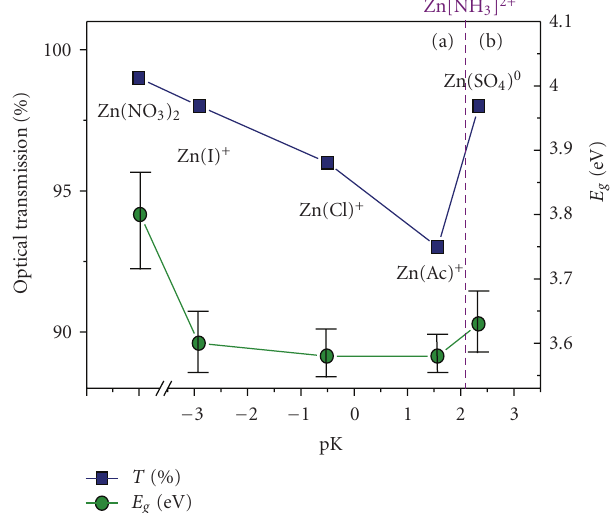
Figure 3: Optical transmission (blue squares) and band gap values (green circles) of ZnS(O,OH) films versus instability constant of Zn complex. The dashed line indicates Zn[NH 3 ] 2+ complex line.